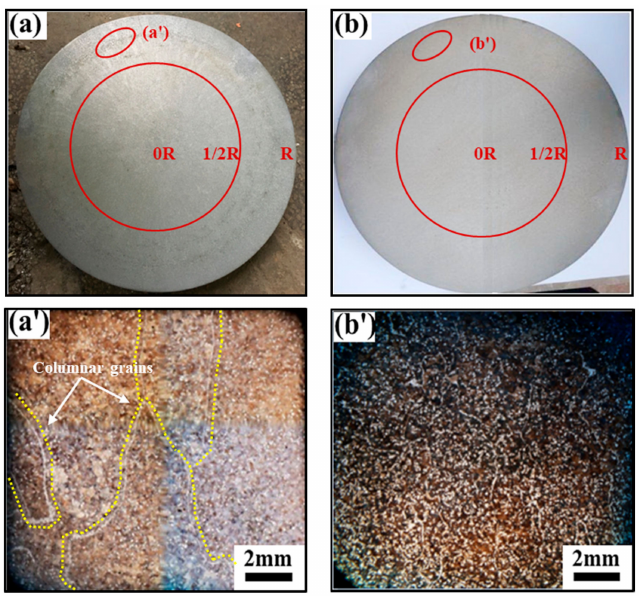
Figure 2. Macro- and microstructure of the ingot: ( a , a (cid:48) ) without ultrasonic; ( b , b (cid:48) ) with ultrasonic.